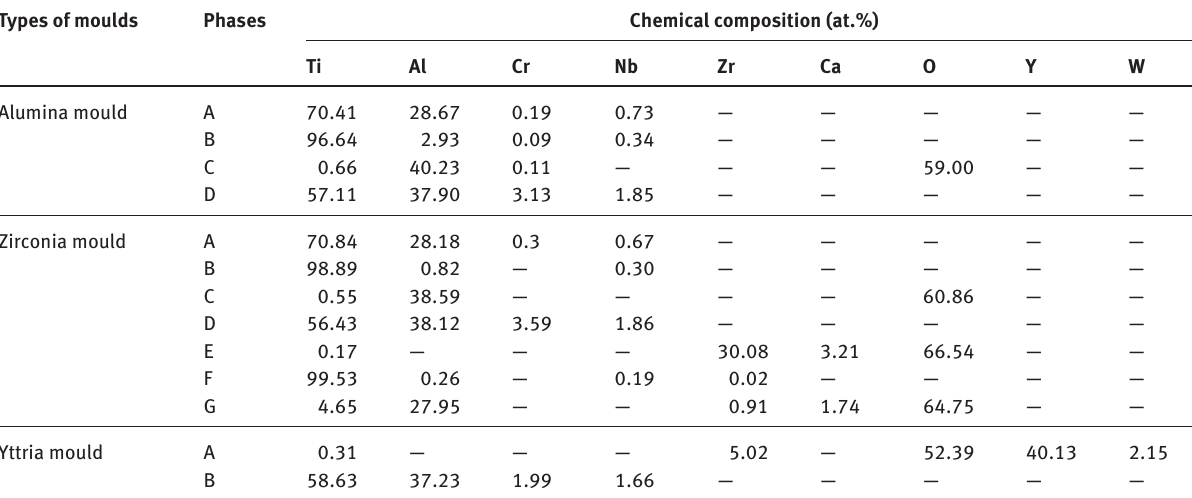
Table 1: The chemical composition of the phases in the reaction regions by different moulds. Types of